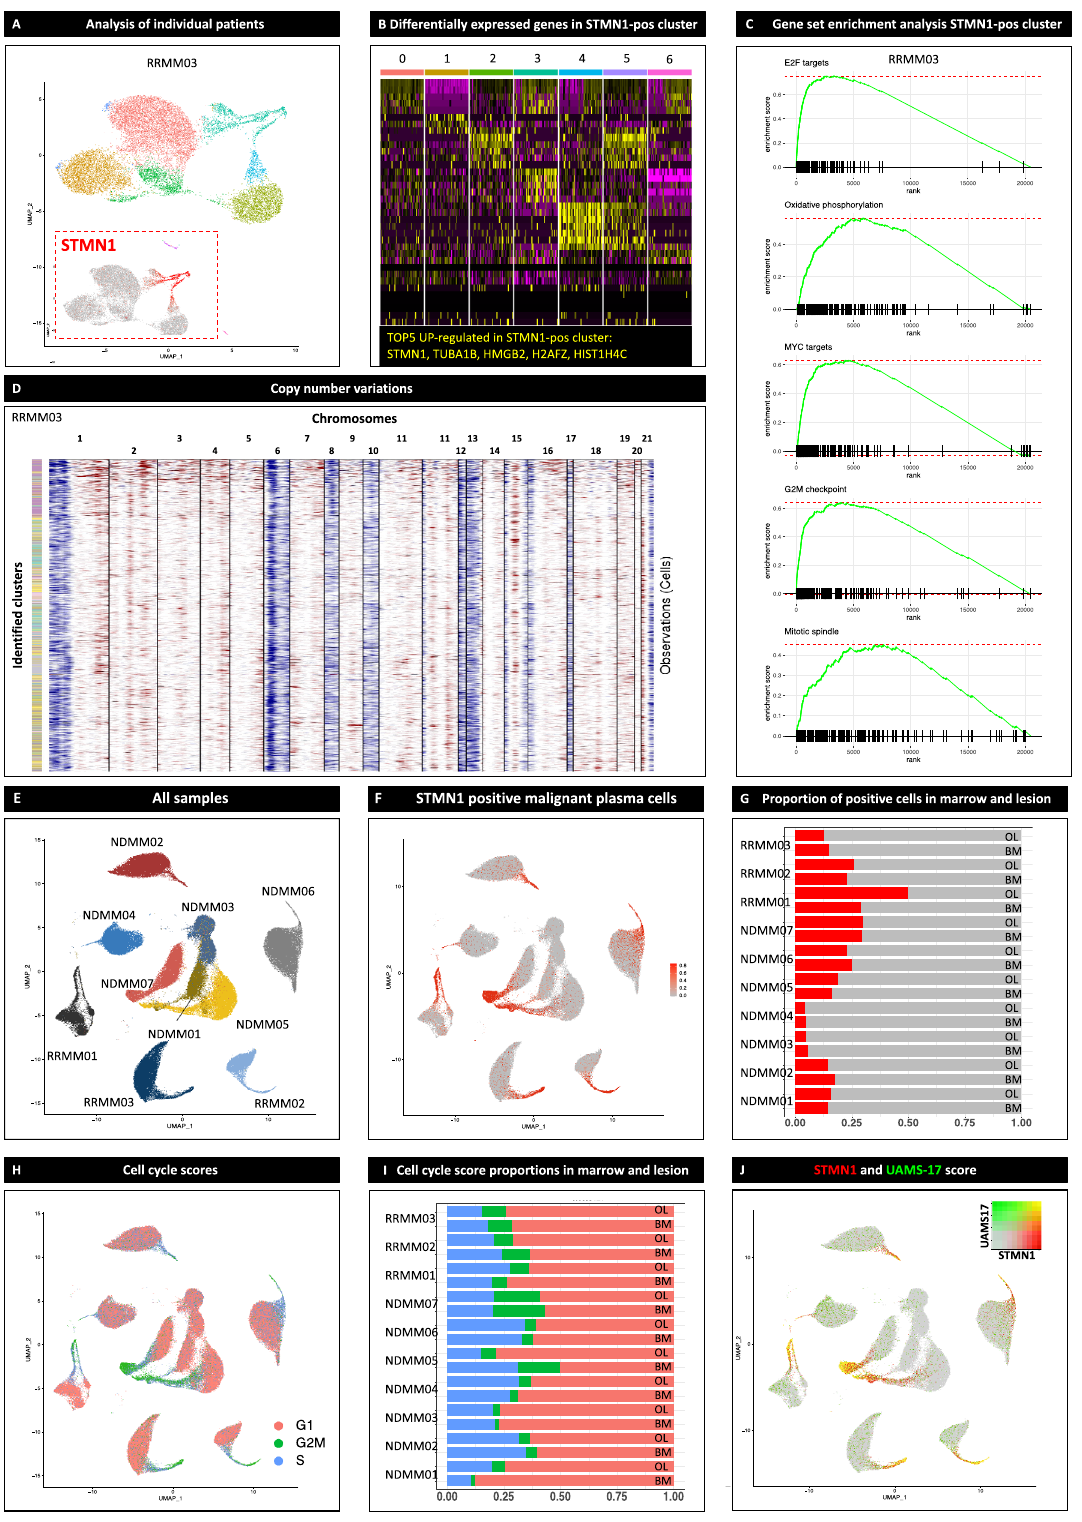
respective genes in PC from the BM and OL. Downregulation of JUN/FOS , DUSP1 and HBB has been connected to extramedullary spread of MM in the past 26 . Furthermore, JUN/FOS are linked to the malignant transformation of B-cells 27 and dissemination of clonal PC in a preclinical model 28 . GSEA con fi rmed that downregulation of genes in pathways associated with normal B-cell was common in PC from the OL (Supplemental Fig.